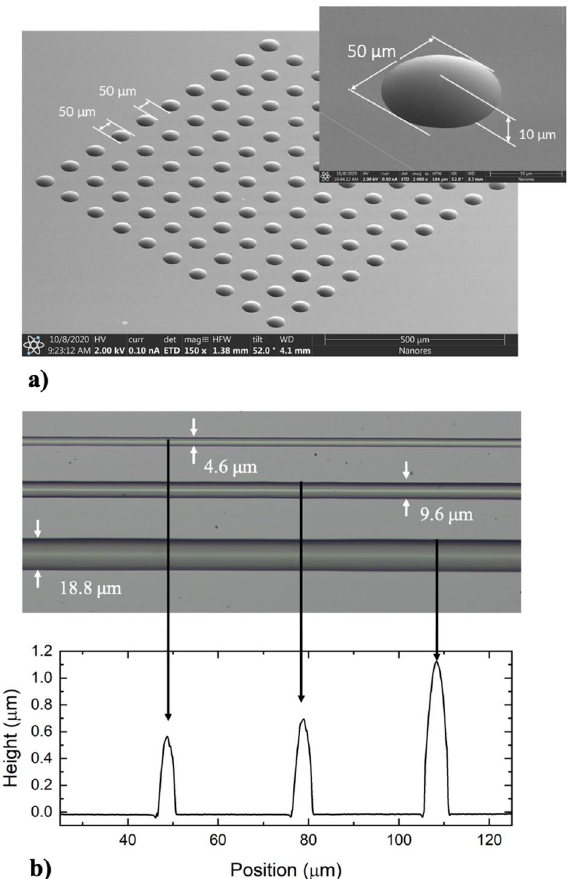
Figure 14. ( a ) Array of microdots printed with photoresist AR P 3110, characterized by the viscosity of 12 cP; ( b ) Set of lines printed using SU-8 photoresist together with the height profiles.